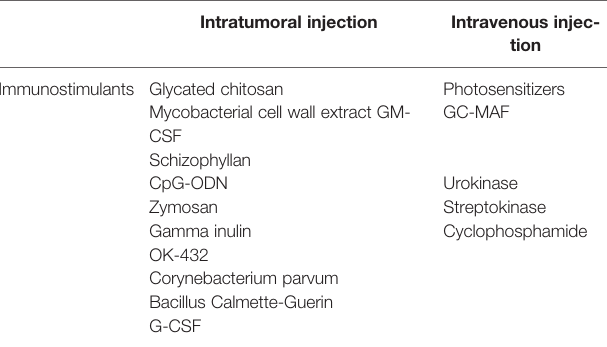
TABLE 1 | Delivery routes (intratumoral injection and intravenous injection) for PDT and immunostimulants. Intratumoral injection